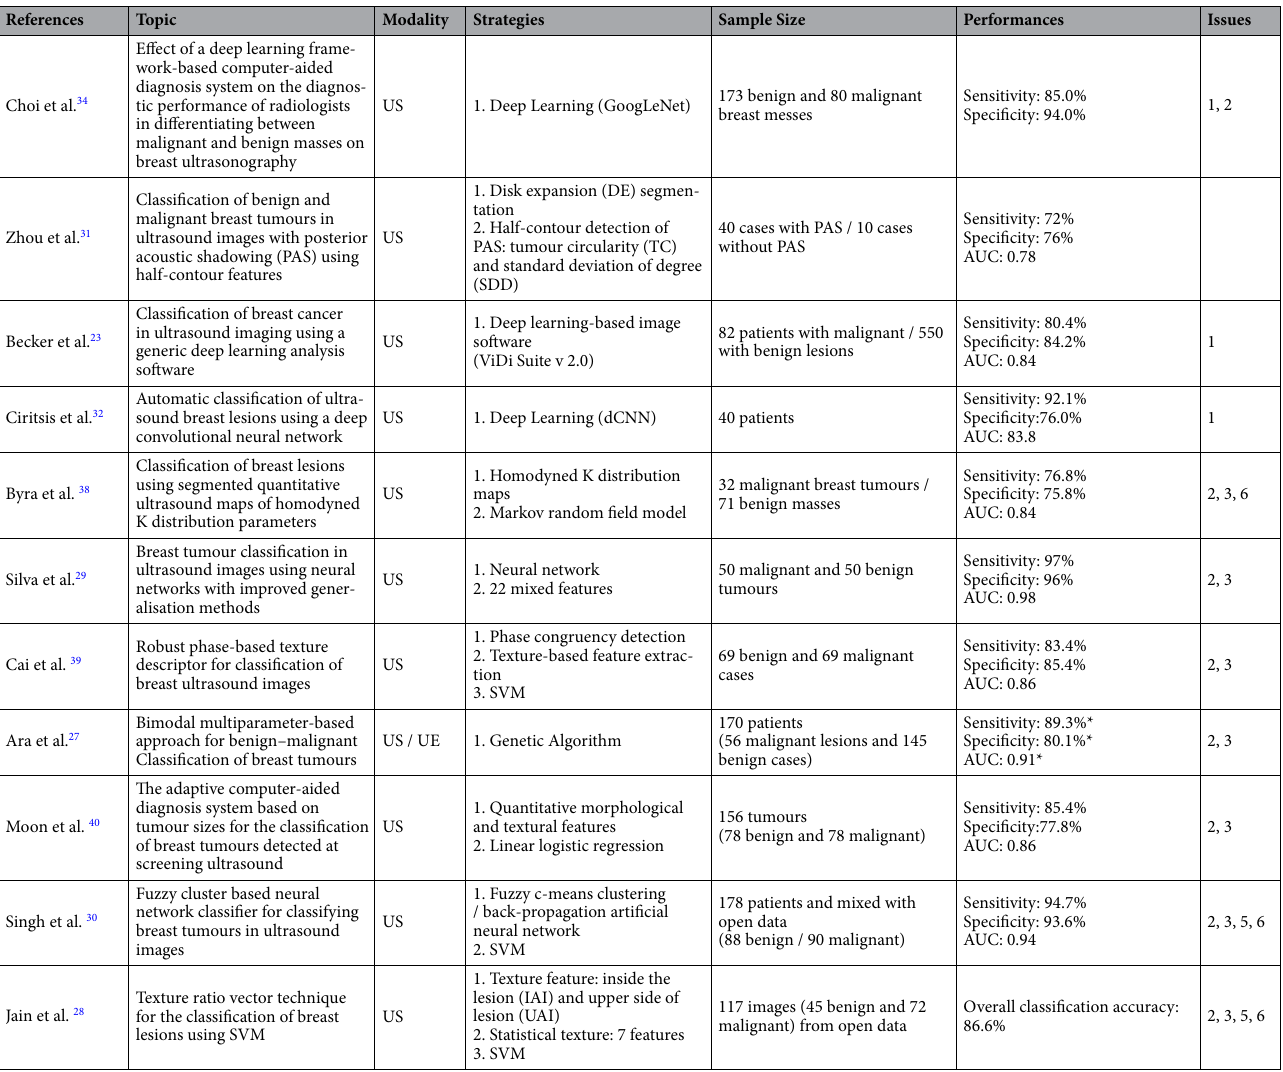
Table 2. Summary of articles in classification of breast tumour. US: ultrasound, UE: ultrasound elastography, CDUS: colour-Doppler flow imaging ultrasound, SMI: superb microvascular imaging ultrasound. *: Report the performance using B-mode US image only. Issues: 1 Not based on machine learning strategies 2 , Using semi- segmentation or contour pre-processing to labelling the tumour region 3 , Feature extracted from only partial US image 5 , Unspecified all cases were tissue-proved 6 , Unspecified ultrasound system